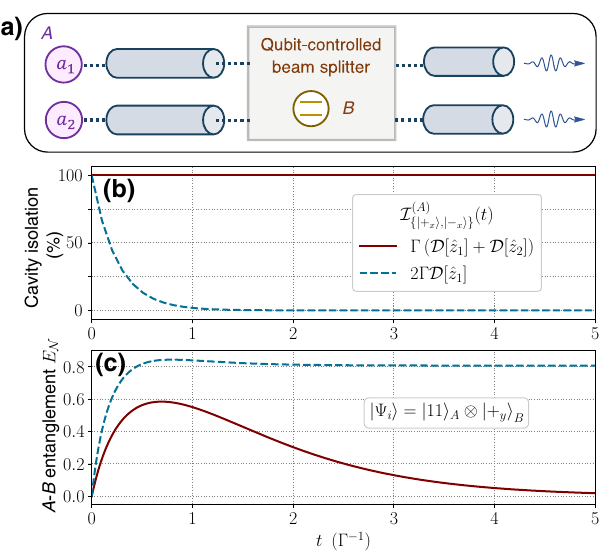
FIG. 4. (a) Schematic illustrating a two-dissipator gauge sym- metry nonreciprocal interaction. Two cavity modes a 1 , a 2 are each coupled to waveguides, which are then sent to a beam splitter that depends on the state of a qubit. The dissipation is described by the Liouvillian (cid:4)( D [ ˆ z 1 ] + D [ ˆ z 2 ] ) [see Eqs. (40) and ( t ) for (42)]. (b) Numerically computed cavity isolation I ( A ) {|+ x (cid:3) , |− x (cid:3)} dynamics generated by the two-dissipator sum (solid red line) versus a single dissipator 2 (cid:4) D [ ˆ z 1 ] (dashed blue curve). The A isolation stays unity in the former case, as expected for any dynamics that is fully nonreciprocal by design [see the discussion on Eq. (40)]. In contrast, individual dissipators from the setup in (a), e.g., D [ ˆ z 1 ], are not unidirectional. For illustrative purposes, the numerics plotted here is restricted to the subspace with at most two photons in A , but our result remains valid for a 1 , a 2 modes with infinite levels. (c) Entanglement (logarithmic neg- ativity E N ) generation by the dissipations, assuming a product (cid:4) (cid:13) (cid:4) + . The fully nonreciprocal interactions initial state | 11 (cid:3) A ⊗ y B generated by (cid:4)( D [ ˆ z 1 ] + D [ ˆ z 2 ] ) creates entanglement (solid red curve), signaling nontrivial influence from the cavity modes to the